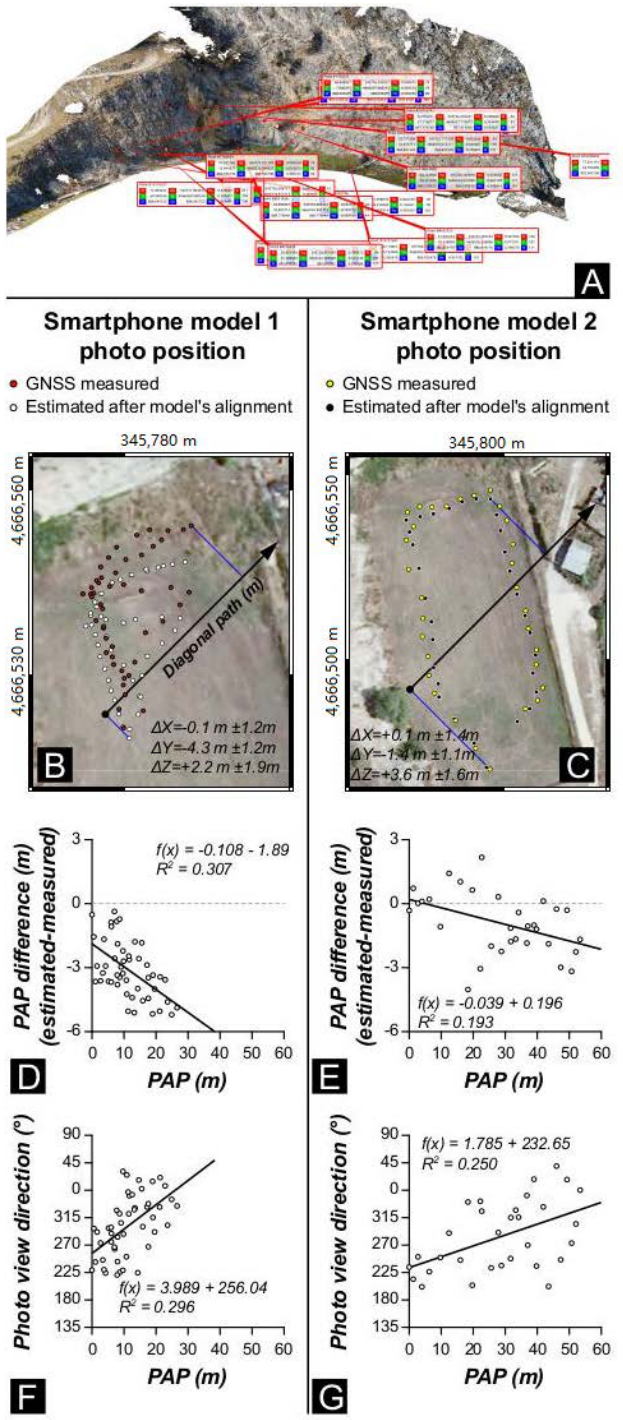
Figure 5. Ground truth smartphone models. ( A ) distribution of the 16 points used to align the smartphone models to the UAV model. ( B , C ) Orthophoto showing the global navigation satellite system (GNSS) measured camera positions and the position of photos as retrieved by the SfM-MVS reconstruction and the subsequent alignment of the smartphone model to the UAV model. ( D , E ) Measured position along the diagonal path (X-axis) vs. the component along the same direction of the di ff erence between the estimated (i.e., reconstructed and then aligned) and measured camera position. ( F , G ) Measured position along the diagonal path (X-axis) vs measured camera